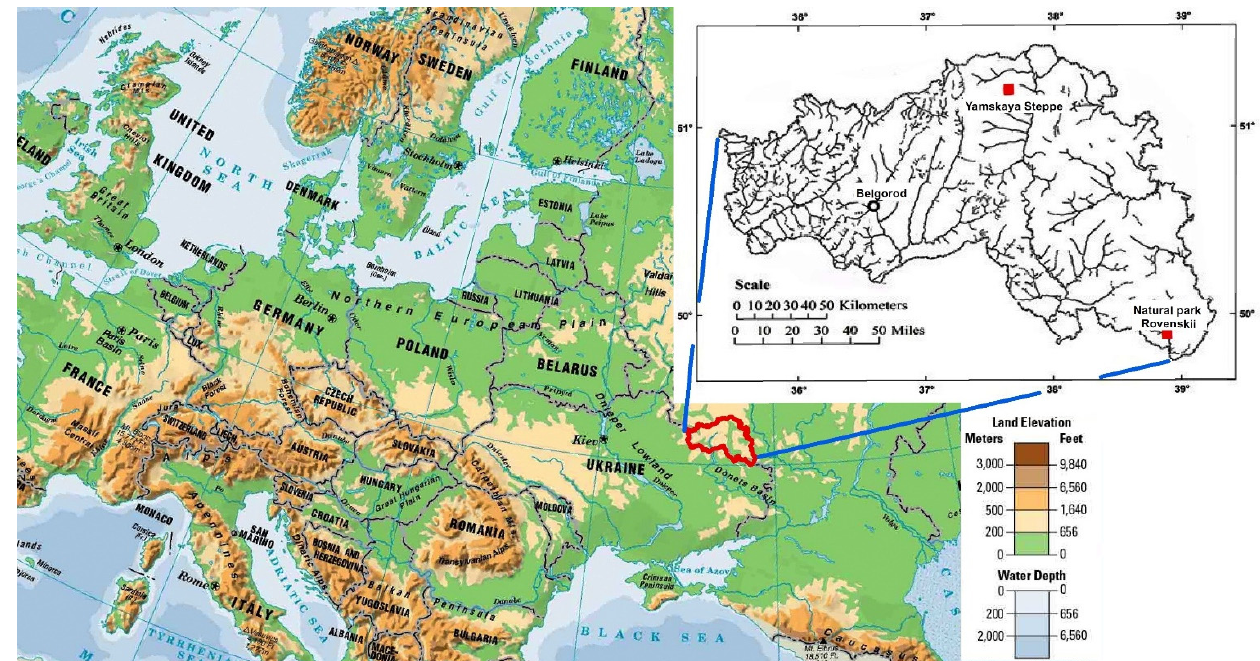
Figure 1. Geographical position of the Belgorod region.